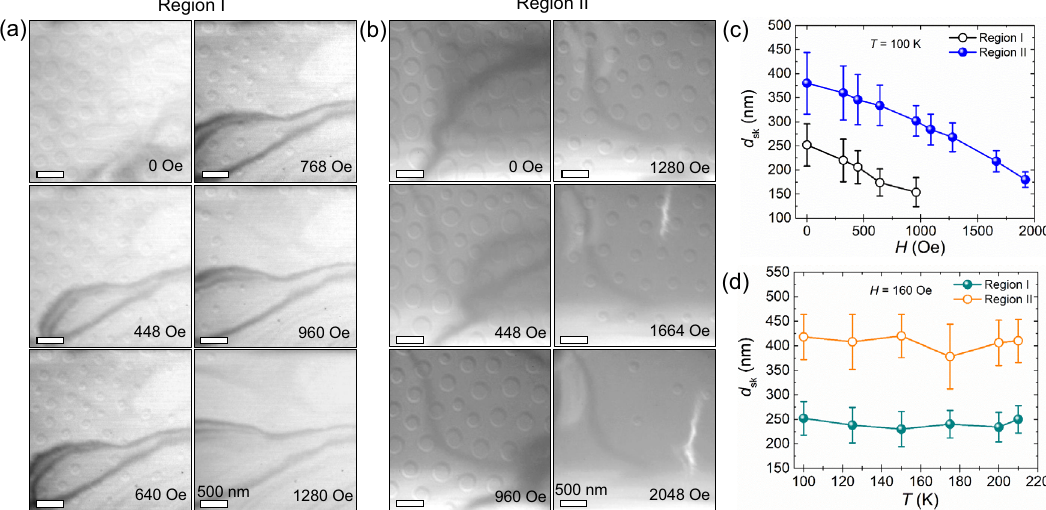
Fig. 5 Thickness-dependent evolution of Néel-type textures in a thin lamella of Cr 1 + δ Te 2 as a function of magnetic fi eld at 100 K. a , b Lorentz transmission electron microscopy image of Néel-type textures recorded at different magnetic fi elds for α = + 6° for lamella thicknesses of a ≈ 75 nm (Region I) and b ≈ 162 nm (Region II). These images are acquired at a defocus value of − 1.5 mm. c Skyrmion diameter ( d sk ) versus magnetic fi eld ( H ) for Regions I and II. d Skyrmion diameter ( d sk ) versus temperature ( T ) for Regions I and II. The dark lines correspond to bending contours. The error bars in c , d represent the standard deviation in the skyrmion